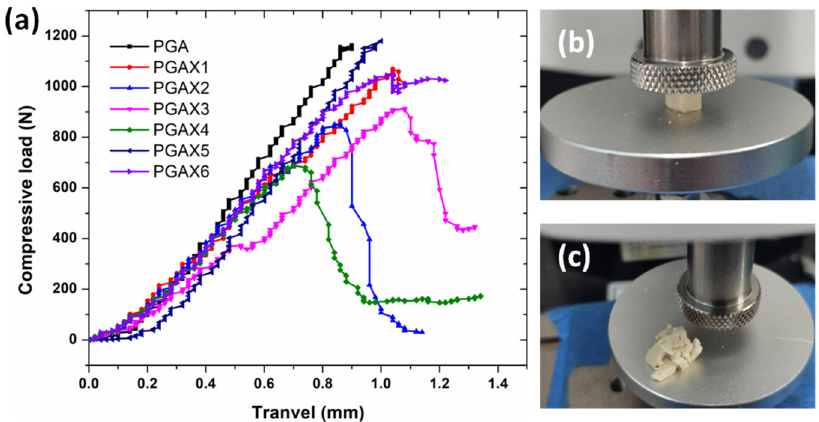
Figure 3. Anti-compression properties of PGA and PGAX blends: ( a ) compressive curves, ( b ) the PGAX3 sample before and ( c ) after compression.